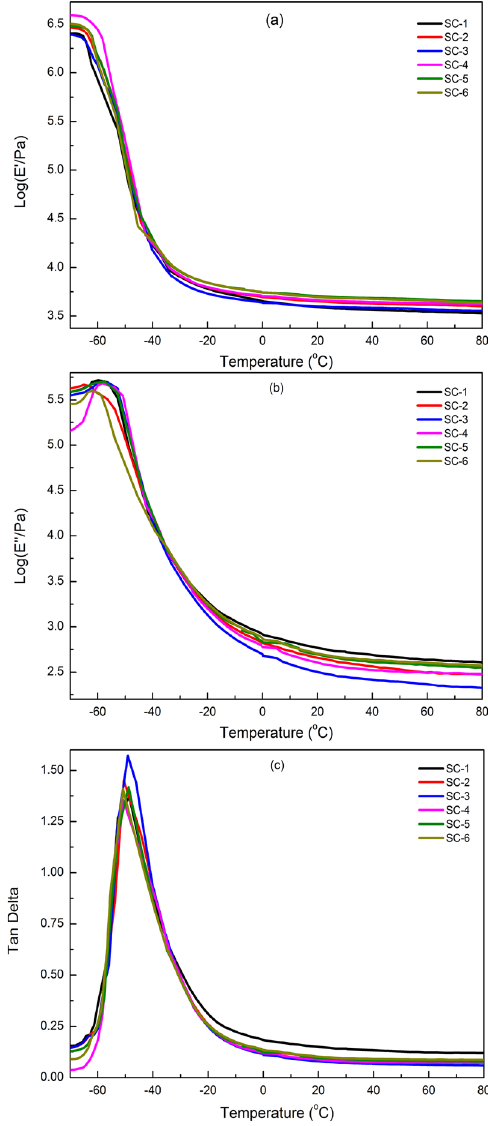
Figure 4: Variation of ( a ) abrasion resistance and ( b ) compression set and rebound resilience with ATD dosage for modi fi ed IR/silica/CB vulcanizates.